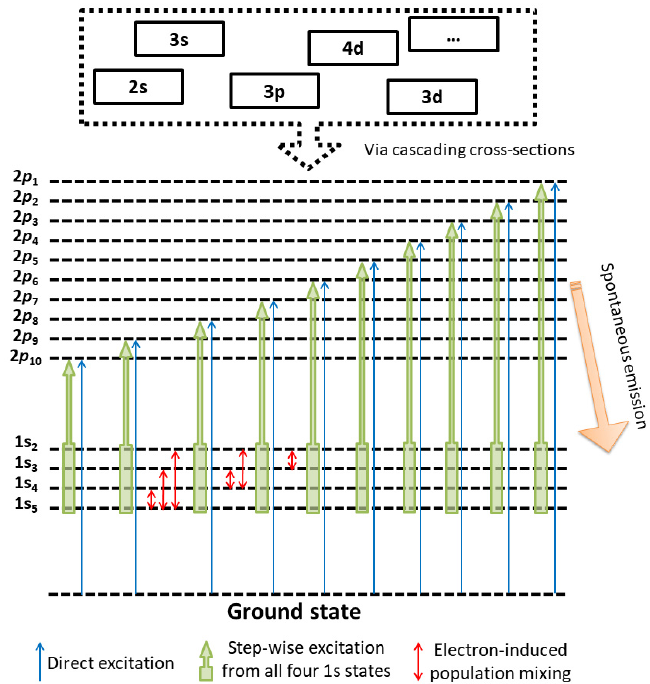
Figure 4. Schematic of the reactions considered in the CR model of argon 2p states.